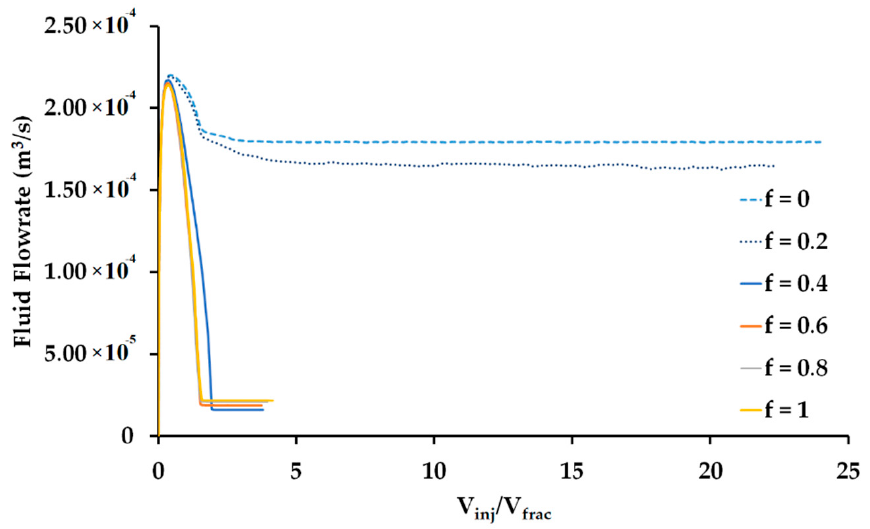
Figure 9. Flowrate at fracture outlet on five different friction coefficients.